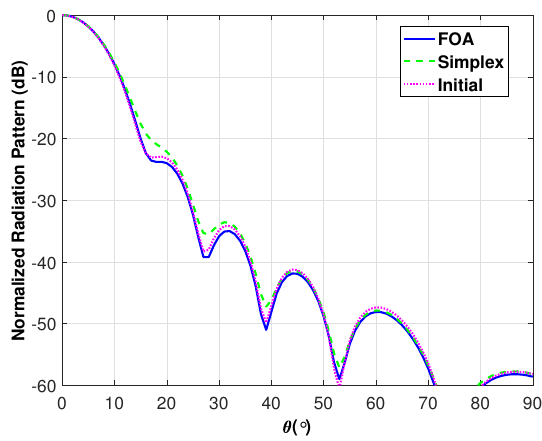
Figure 7. Normalized radiation pattern at 94 GHz of the of the optimized Potter Horn (H-Plane).